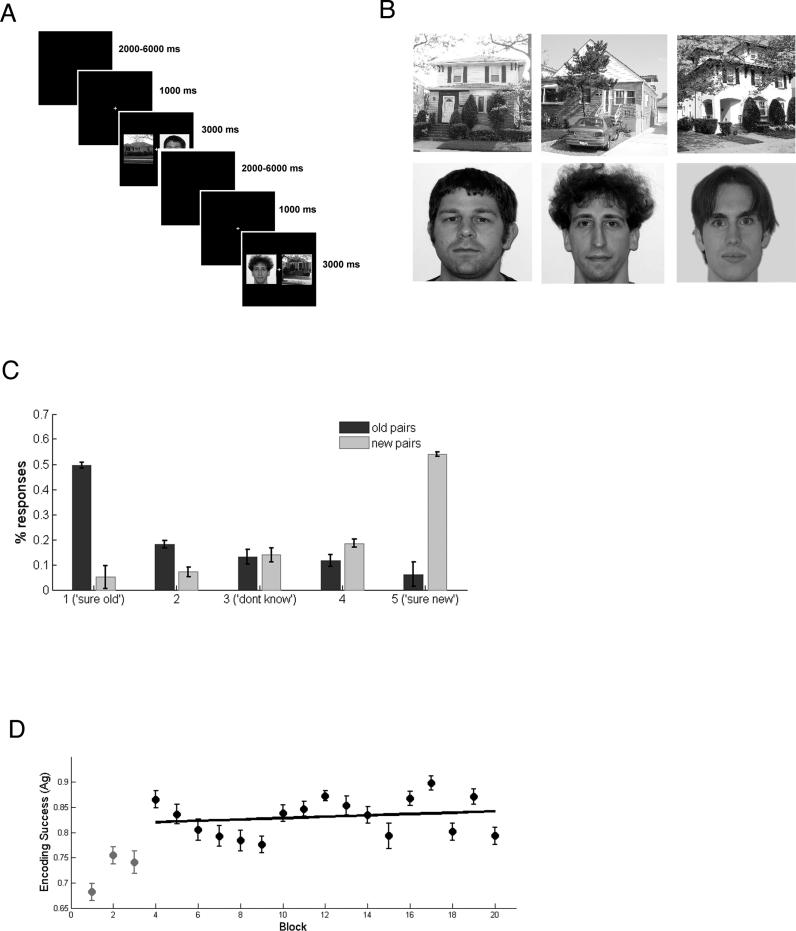
Task and Behavioral Data(A) Selected events (2 trials) comprising part of the encoding phase. At the side of each frame, the amount of time for which it was presented is indicated.(B) Examples of the face and house stimuli employed.(C) Proportion of responses to old pairs (dark gray bars) and new pairs (light gray bars) falling in each of the five reponse categories (shown on the
x-axis: 1 [“sure old”] through 5 [“sure new”]).
(D) Encoding success (the area under the ROC curve, or A
g) averaged across participants for each block. Bars are standard errors. The first three blocks were outliers (in gray). The black line is a fitted linear trend, which was nonsignificant (F < 1).